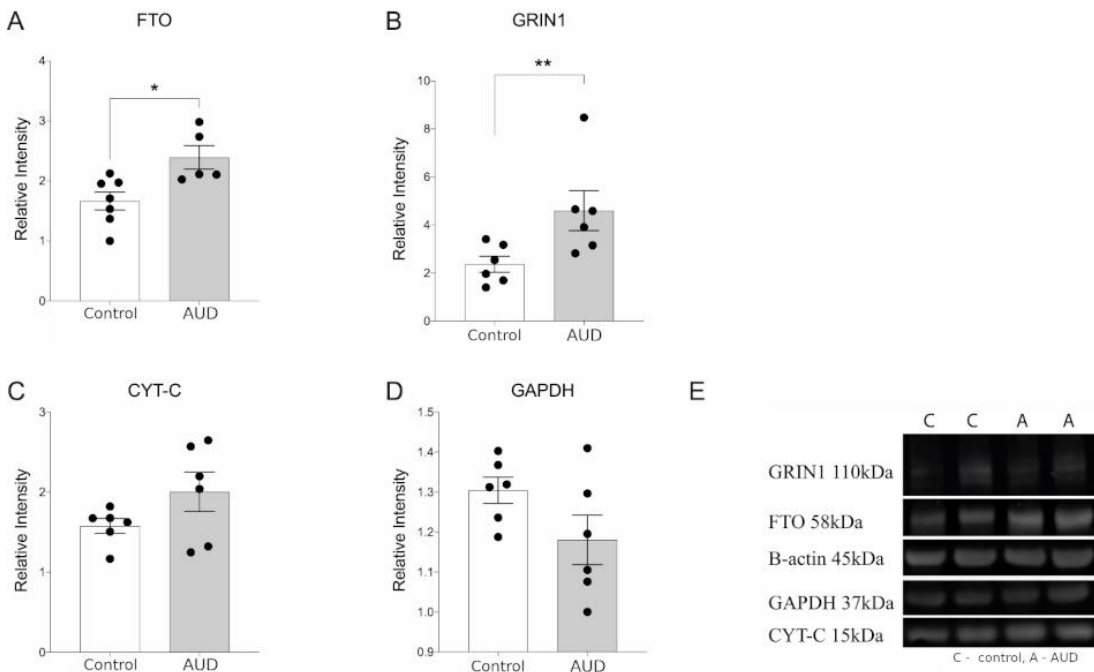
Figure 4. Protein expression in thalamus of AUD and control subjects—( A ) FTO–FTO Alpha-Ketoglutarate Dependent Dioxygenase, ( B ) GRIN1—glutamate ionotropic receptor NMDA type subunit 1, ( C ) Cyt-C—Cytochrome c, ( D ) GAPDH—Glyceraldehyde 3-phosphate dehydrogenase, and ( E ) representative immunoblots. Data are expressed as mean values ± SEM ( n = 5–6). Statistical analysis was performed with unpaired t-test with Welch’s correction. * p ≤ 0.05, ** p ≤ 0.01 when compared with controls.